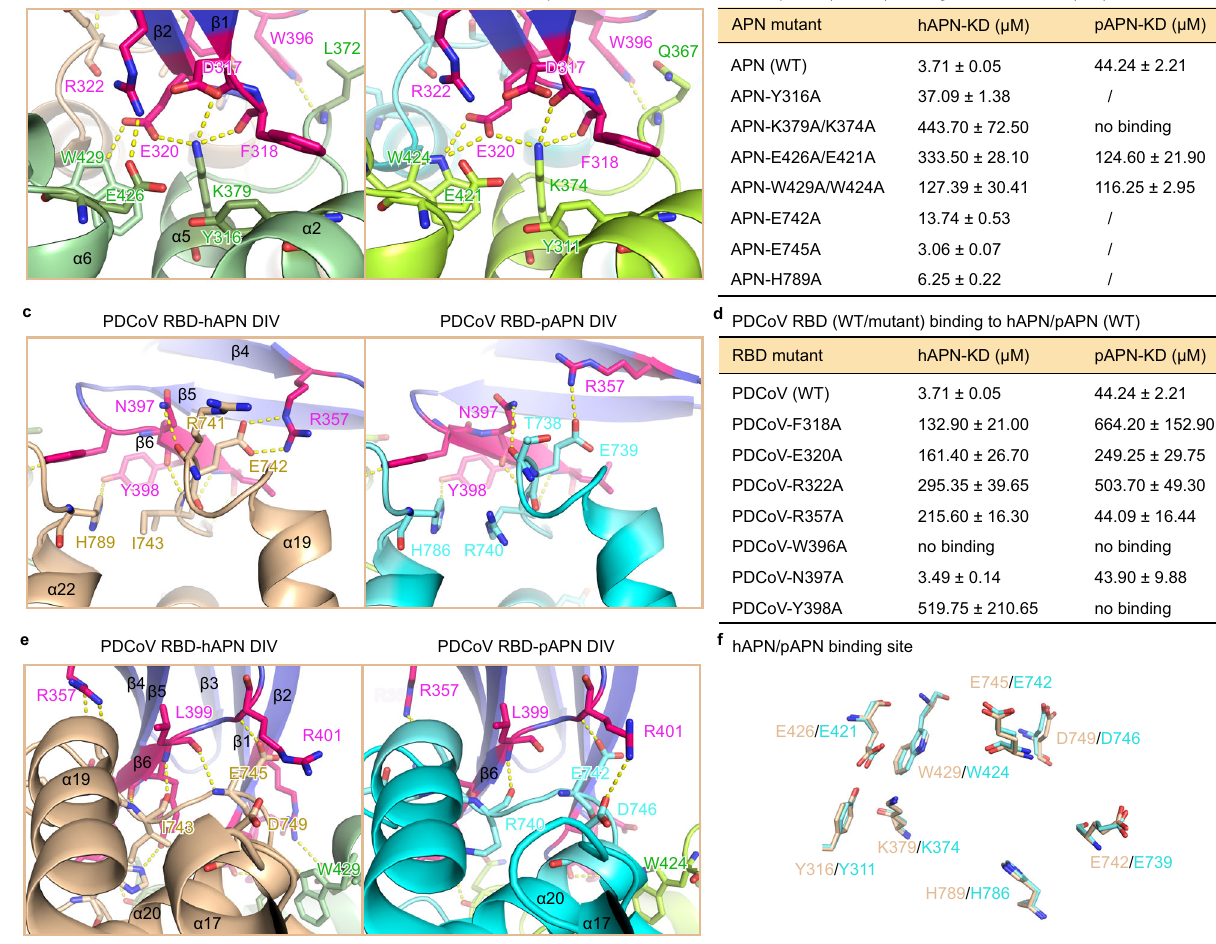
Fig. 3 PDCoV recognizes conserved residues on human and porcine APN receptors. a , c , e Atomic details of the interaction between PDCoV RBD and hAPN/pAPN. Contacting residues on respective proteins are represented as sticks, with nitrogen and oxygen atoms colored in blue and red, respectively. PDCoV RBD are shown in purple while different domains of hAPN/pAPN are colored as in Fig. 2a, b. b Analysis of the binding of PDCoV RBD to wildtype (WT) and mutant hAPN/pAPN proteins using surface plasmon resonance (SPR). The af fi nities of the interacting proteins are calculated as average values from two experiments, with standard deviation included. n.b. stands for no binding. / indicates the interactions have not been measured. d Analysis of the interaction between wildtype hAPN/pAPN and PDCoV RBD wildtype (WT)/mutant proteins using SPR. f Superposition of key residues on hAPN and pAPN that bind to PDCoV RBD. The side chains of these residues are well aligned in position. Values for binding af fi nity are provided as a Source Data fi